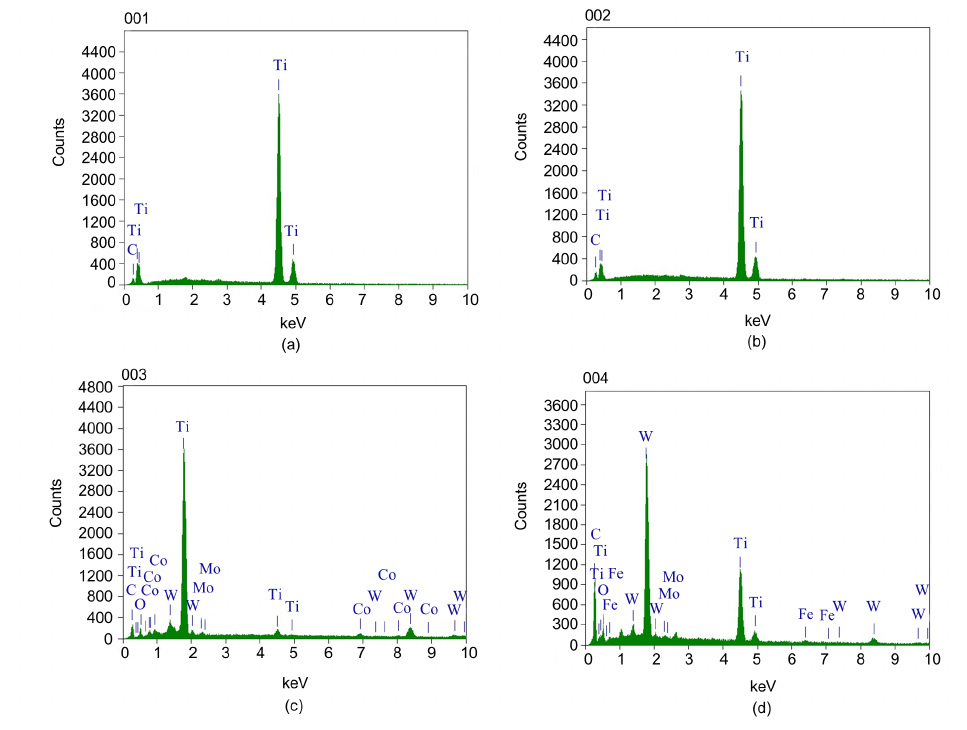
Figure 7. Energy spectrum analysis. ( a ) 001 region; ( b ) 002 region; ( c ) 003 region; ( d ) 004